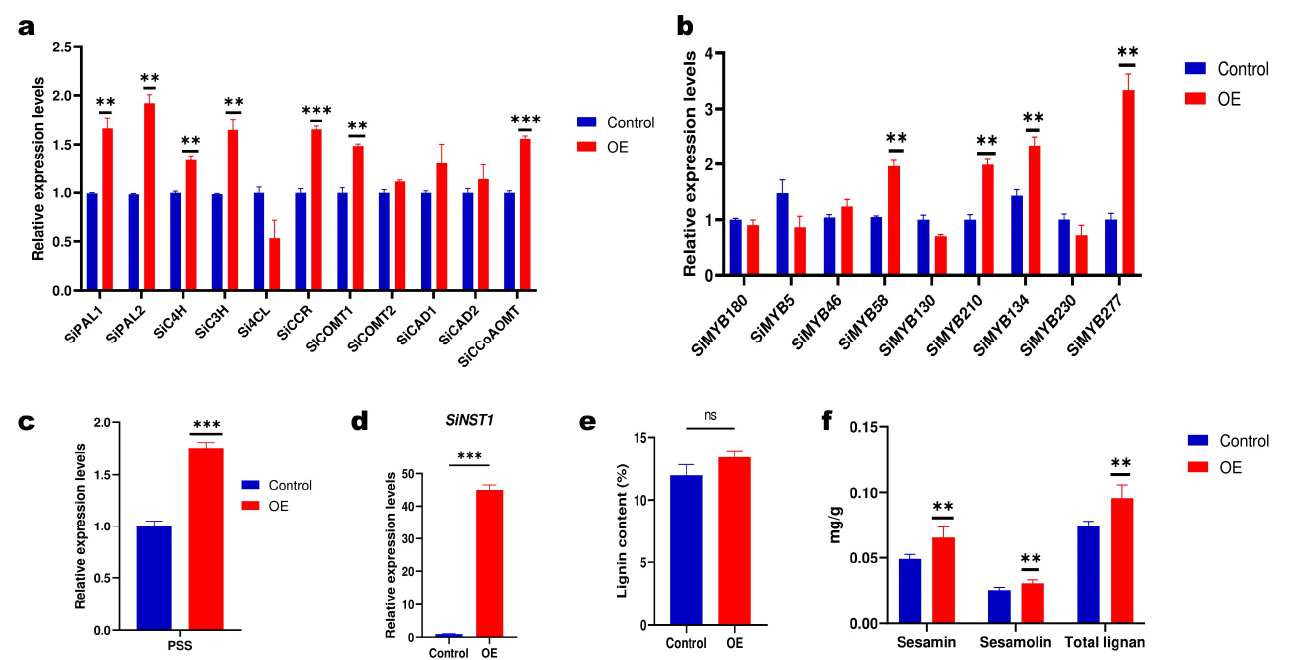
Figure 6. Functional validation of SiNST1 in sesame hairy roots. ( a ) Expression analysis of monolignol biosynthetic genes. ( b ) Co-expressed SiMYBs with SiNST1 predicted to involve in lignin biosynthesis. ( c ) piperitol/sesamin synthase, PSS. ( d ) SiNST1 . ( e ) Lignin content. ( f ) Lignans content in transgenic sesame hairy roots. *** P < 0.001; ** P < 0.01; t -test.